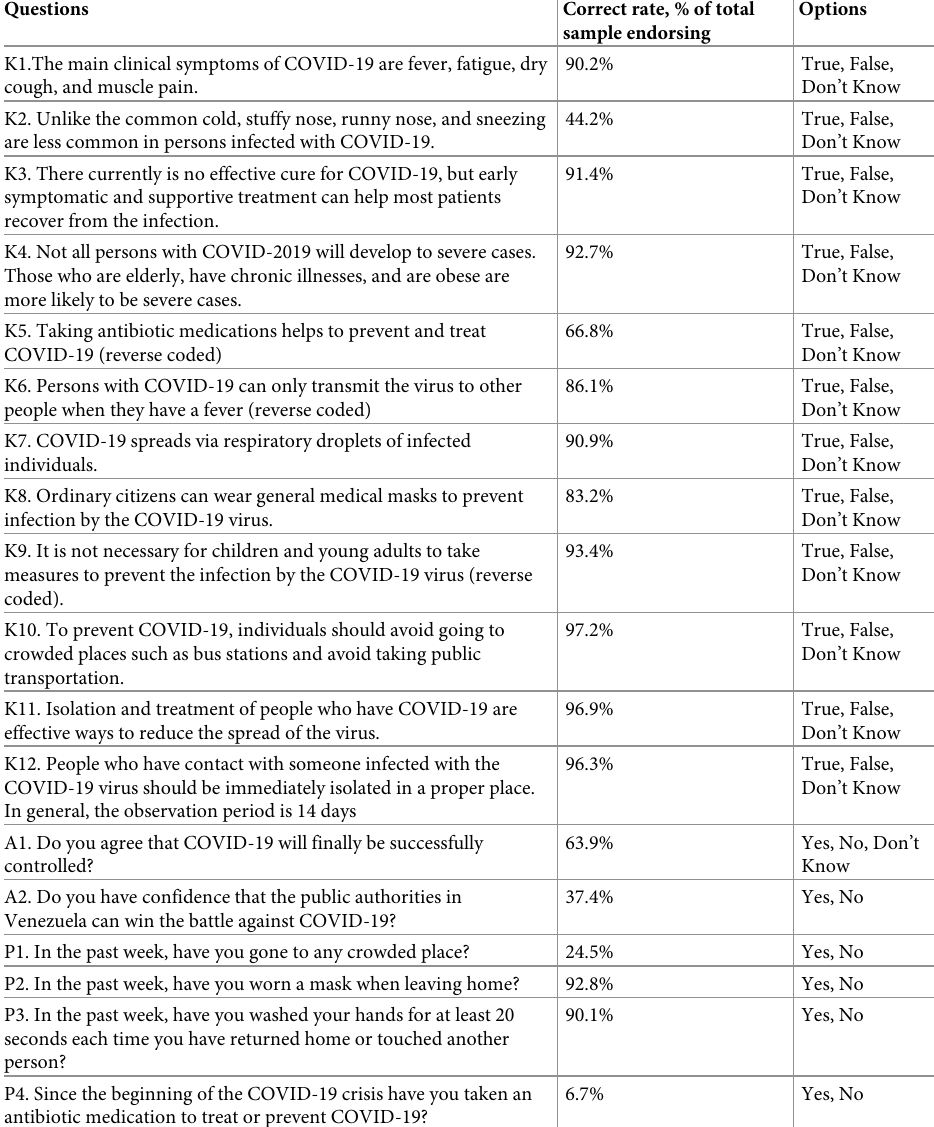
Table 1. Knowledge, attitudes, and practice towards COVID-19.